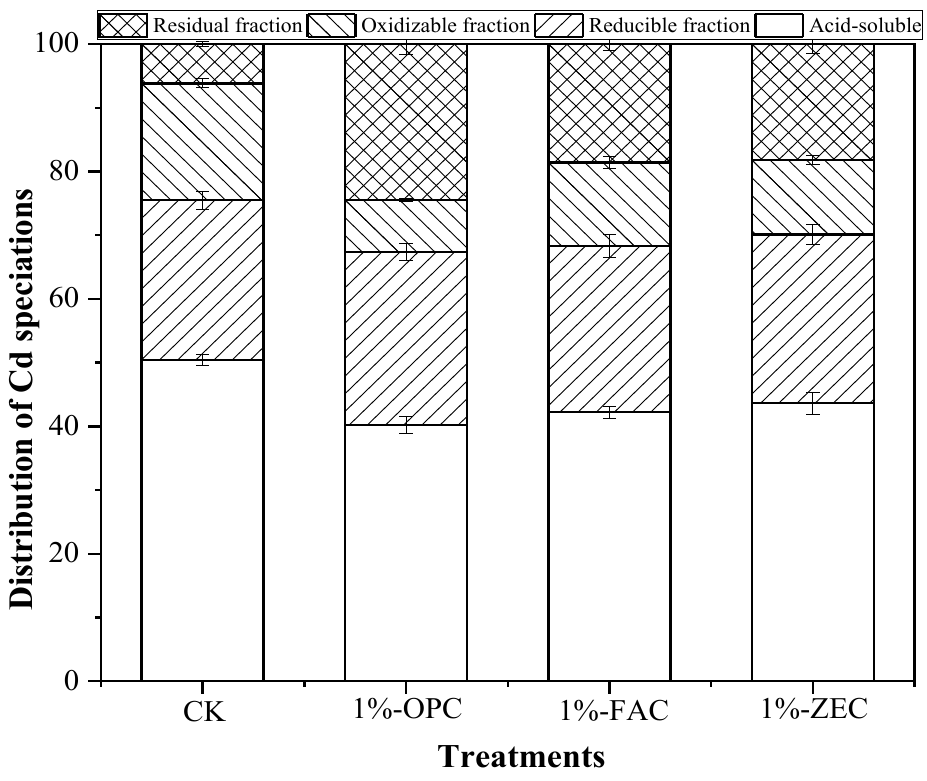
Figure 6. Amendments effect on Cd speciations. Treatments: control (CK), cement paste (OPC), fly ash cement (FAC) paste, and zeolite cement (ZEC) paste.